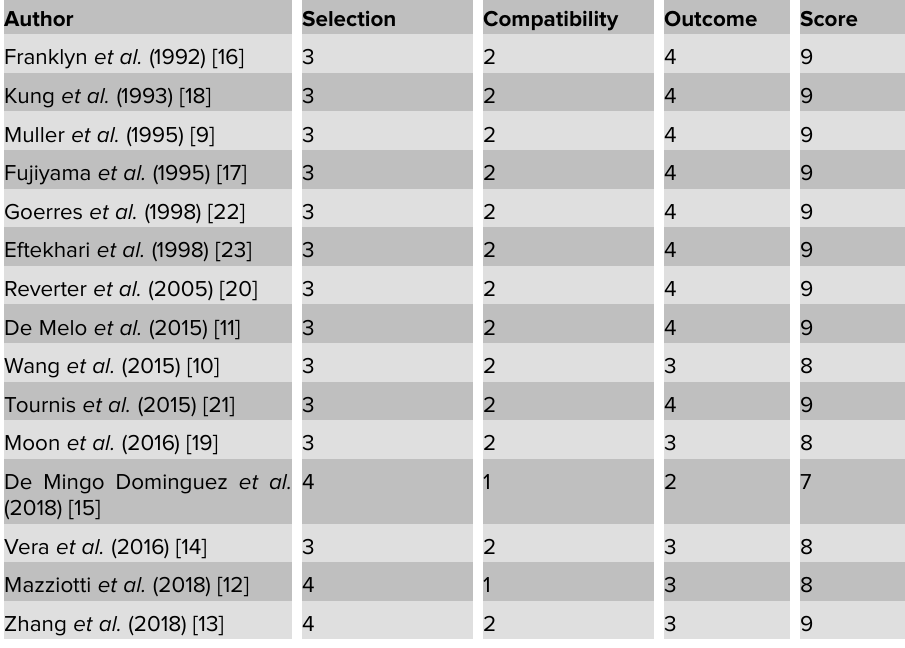
Table 1: Ottawa Newcastle assessment for the included